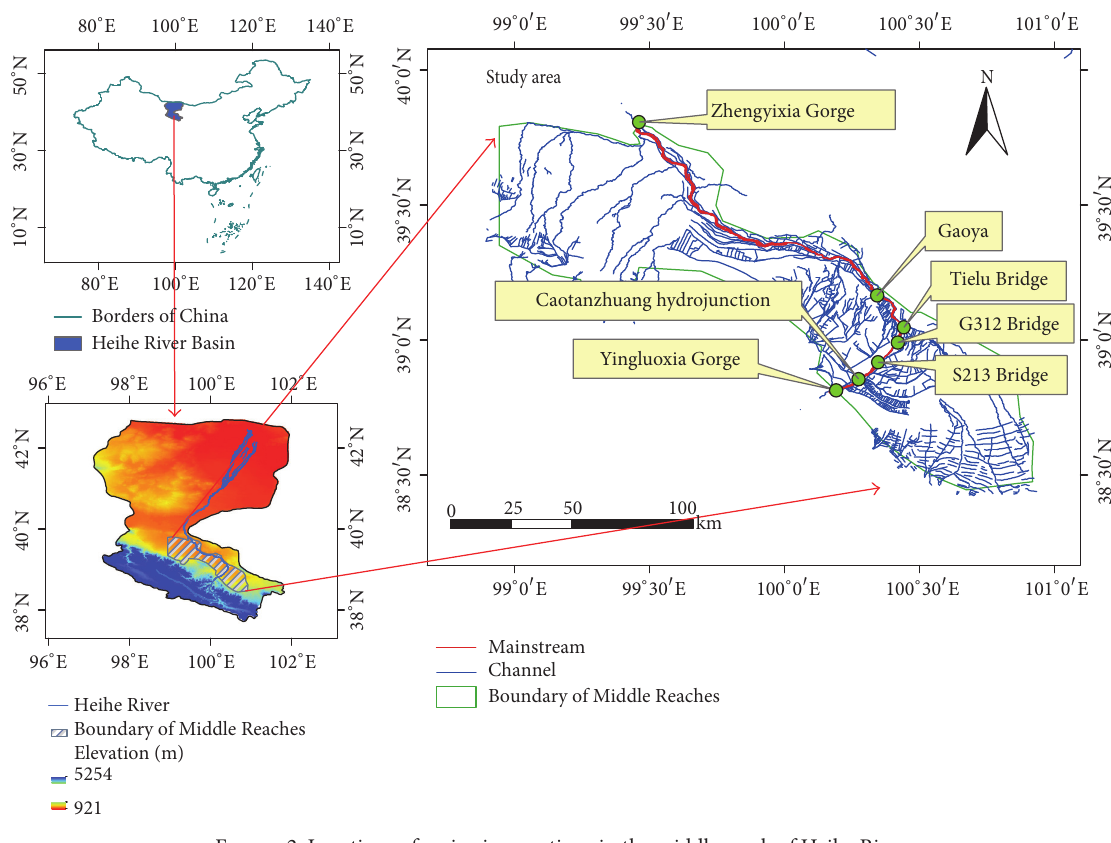
Figure 2: Locations of main river sections in the middle reach of Heihe River.